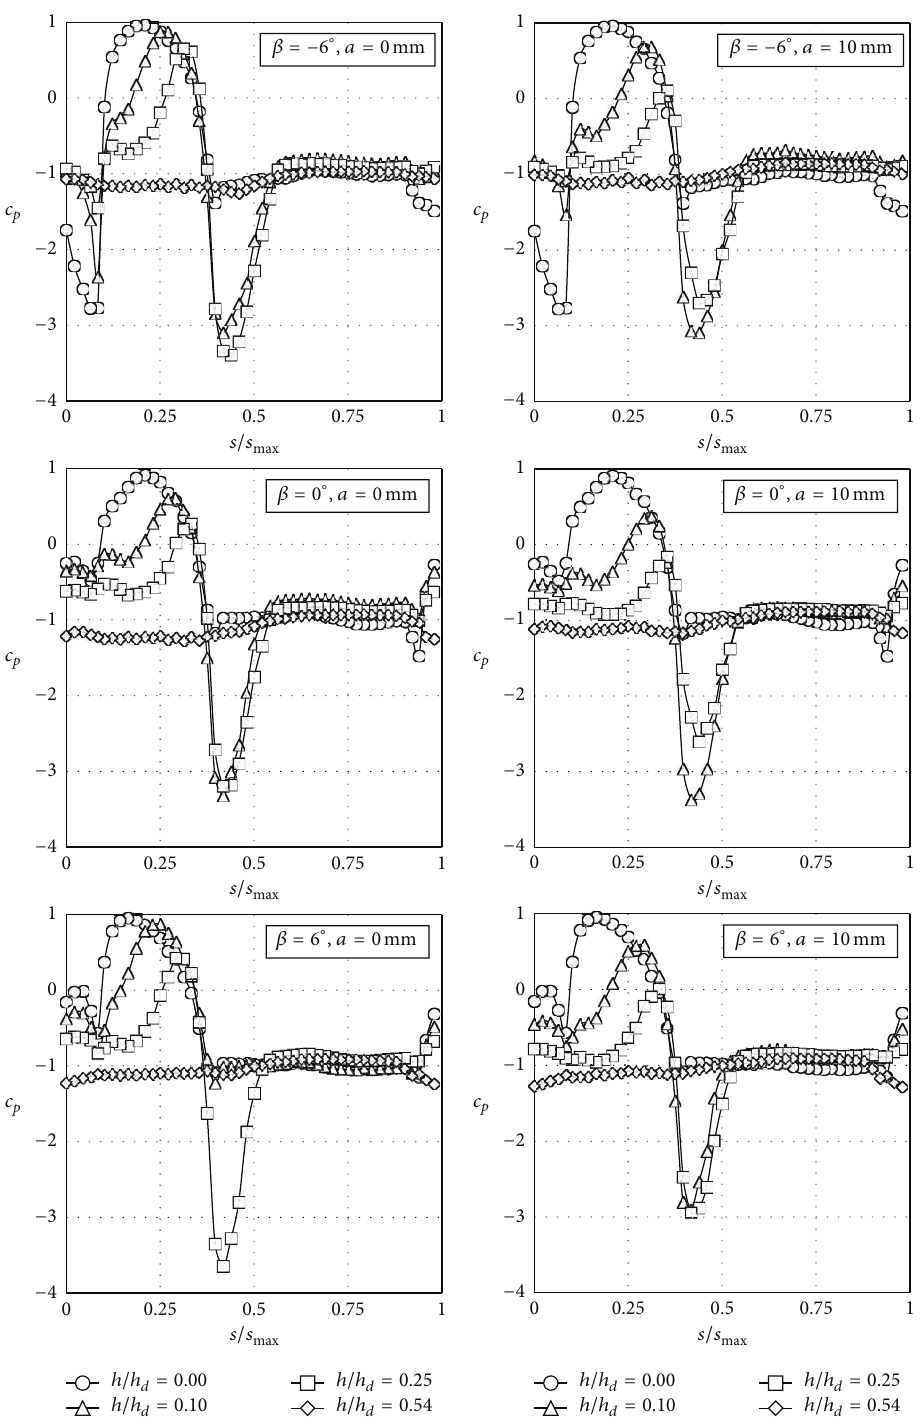
Figure 7: Pressure coefficient, 𝑐 𝑝 , distributions with the coach placed on the windward railway track on an embankment with a slope 1:2, as a function of the nondimensional distance over the train surface at the middle cross-section, 𝑠/𝑠 max (see Figure 4(b)).